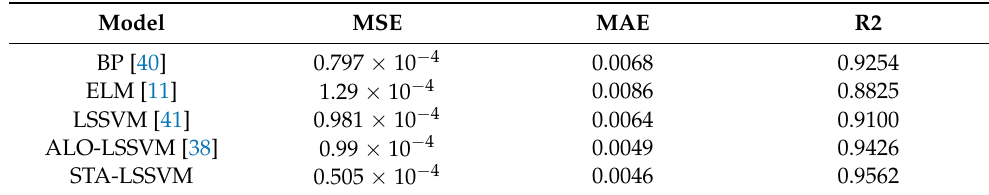
Table 4. Index of the voltage estimation with different models.